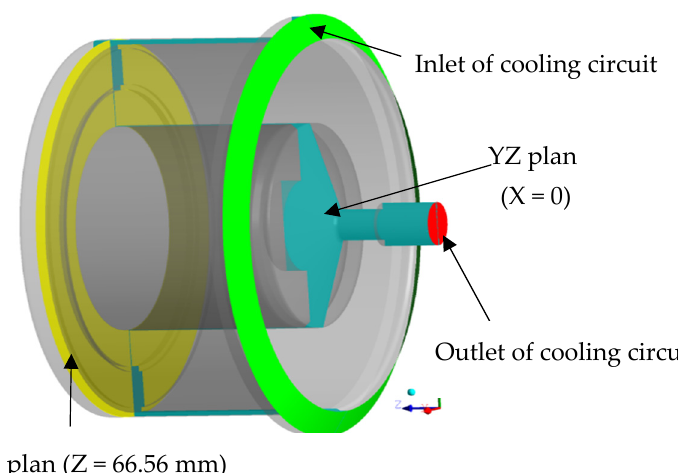
Figure 10. Section position of the cooling circuit.